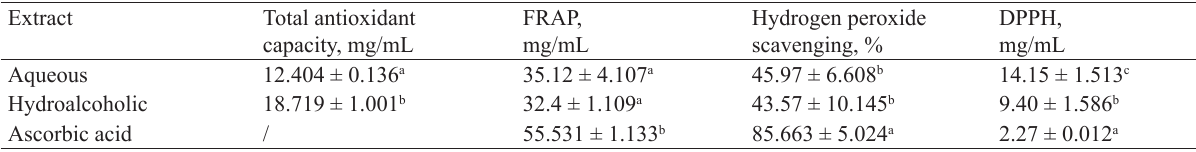
Table 2 Antioxidant activity of pomegranate extracts Extract